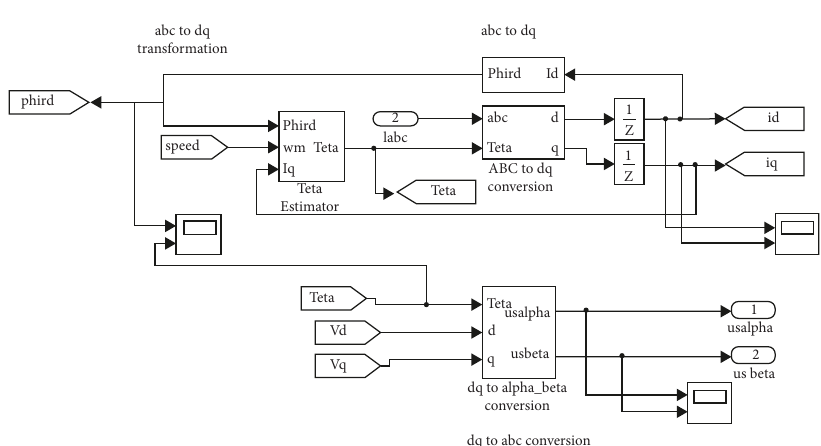
Figure 14: Te subsystem of abc to